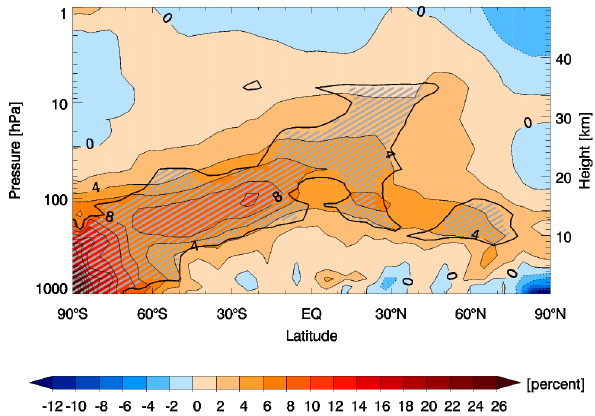
Fig. 4. Annual mean effect of GCRs on zonal mean HNO 3 , ([HNO 3 ] GCR -[HNO 3 ] control ) /[HNO 3 ] control , in percent. Results are averaged from 1978-2002 (after allowing for a 2-year model spin-up) with appropriate accounting for solar minimum and max- imum periods. Hatched areas (enclosed by thick solid contours) indicate changes with at least 95% statistical significance.